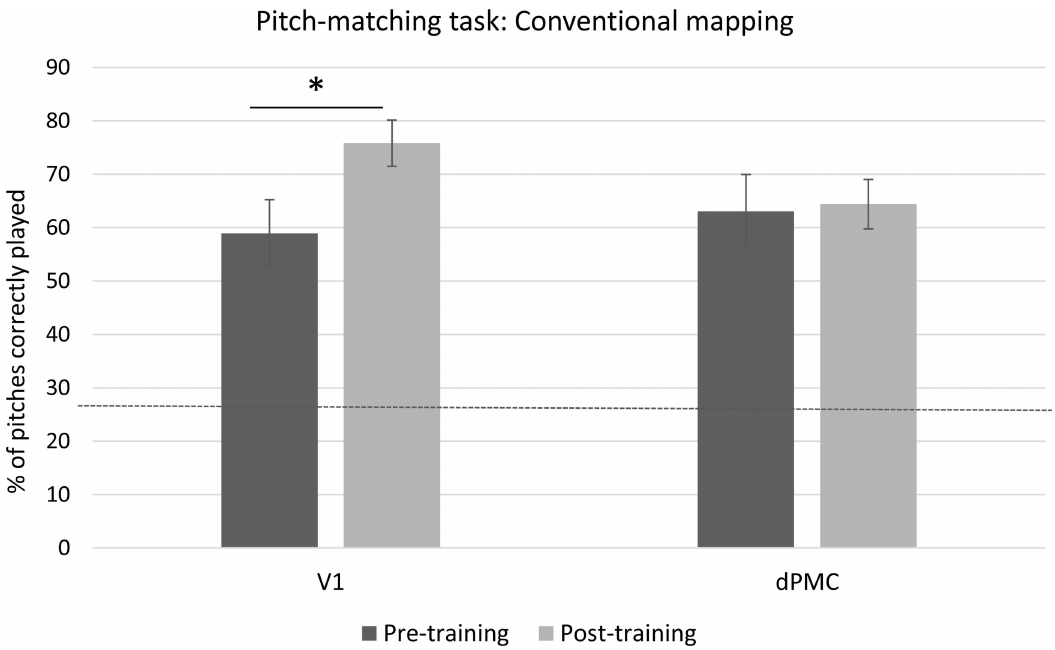
Fig 4. Results of the Pitch matching task of Experiment 1 (ordered mapping). Columns represent averagedata with standard error bars. The y-axis represents percent correct scores plotted across the TMS site (dPMC and V1). As indicatedby the asterisk, TMS over the dPMC significantly reducedparticipants’accuracy compared to the V1 stimulation. Horizontal dashedline indicates the level of chance (25%).